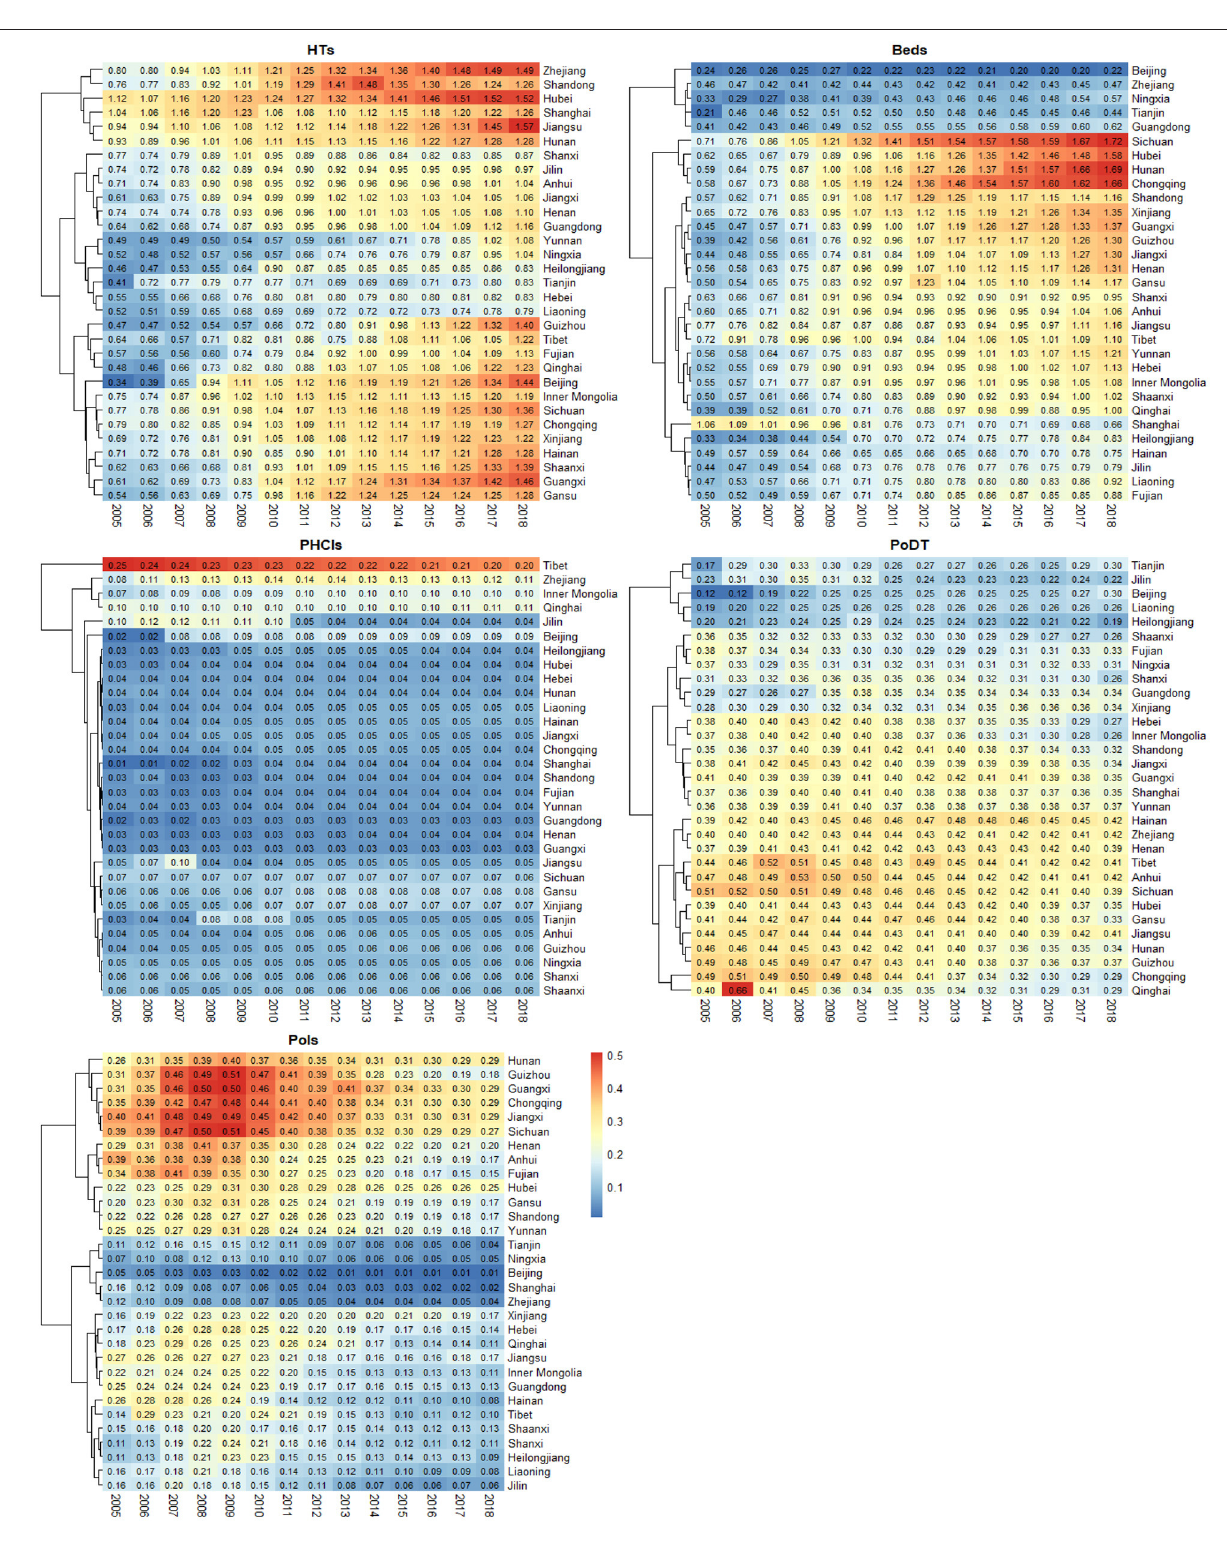
Frontiers in Public Health |